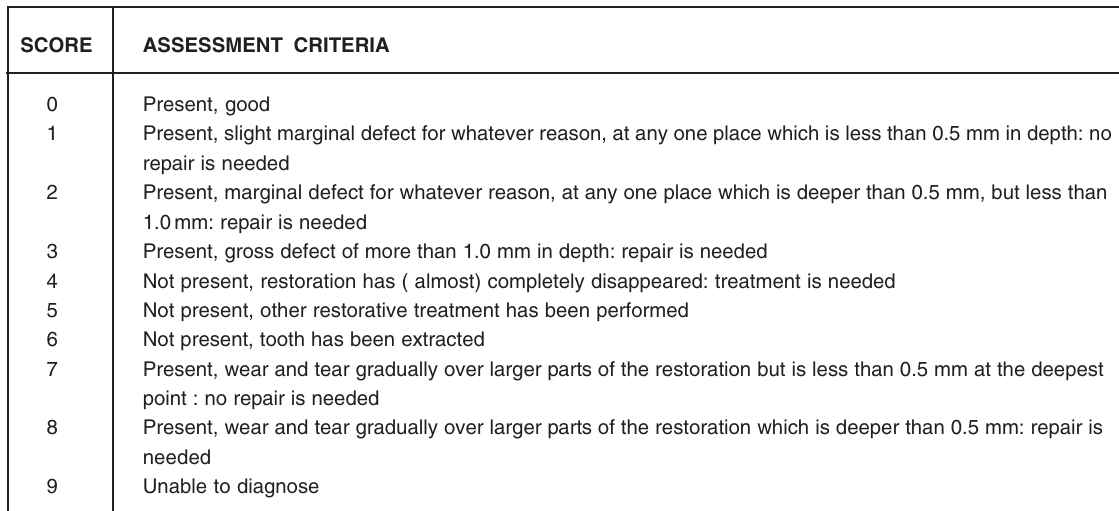
(6)0, 1 and 7=successful; 2, 3, 4 and 8=failure; 5, 6 FIGURE 2- Clinical criteria used to evaluate ART restorations